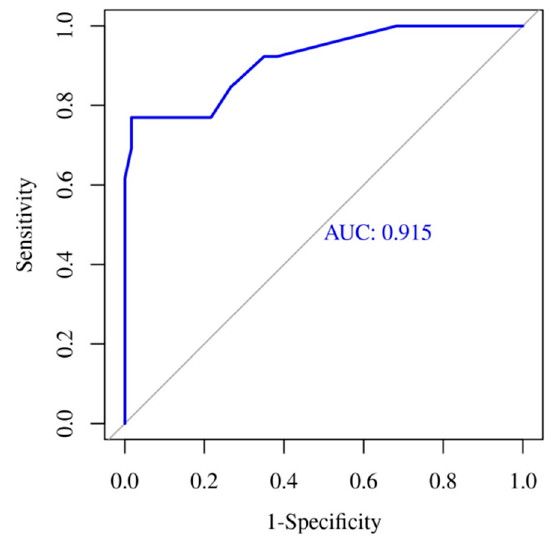
Figure 5. Multivariate ROC Curve for biomarkers at second evaluation (2vs1 variables included).